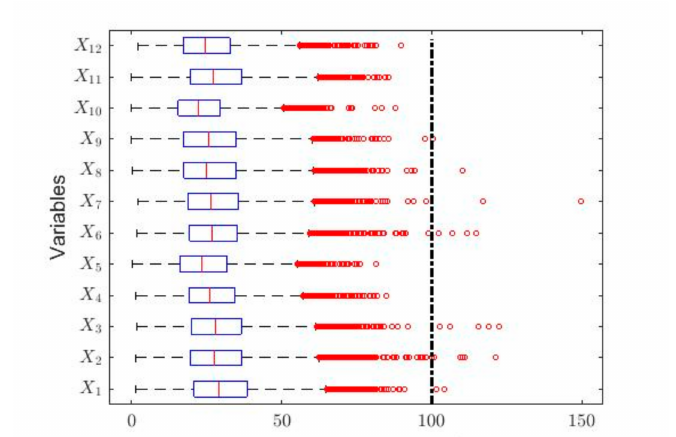
Figure 1. Box plots of the variables. The outliers are shown by using red circles and, according to QAQI [8], the dashed straight line indicates the separation between the desirable level of pollution (i.e., (cid:104) (cid:17) 0,100 µ g/m 3 ) and the acceptable level of pollution (i.e.,